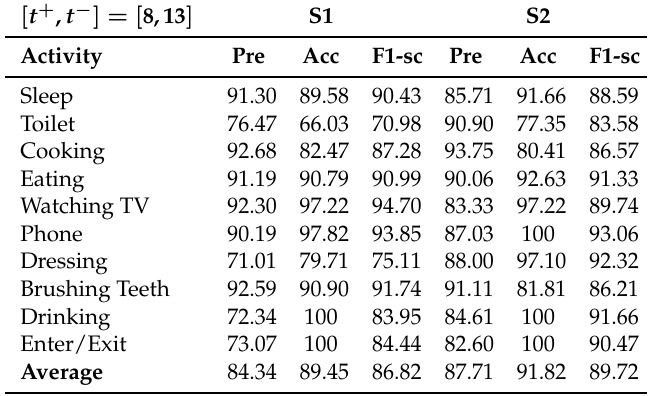
Table 7. S1: Non Binary (inertial + location) sensors. S2: non-location (binary + inertial), S3: non-inertial (binary + location), S4: only